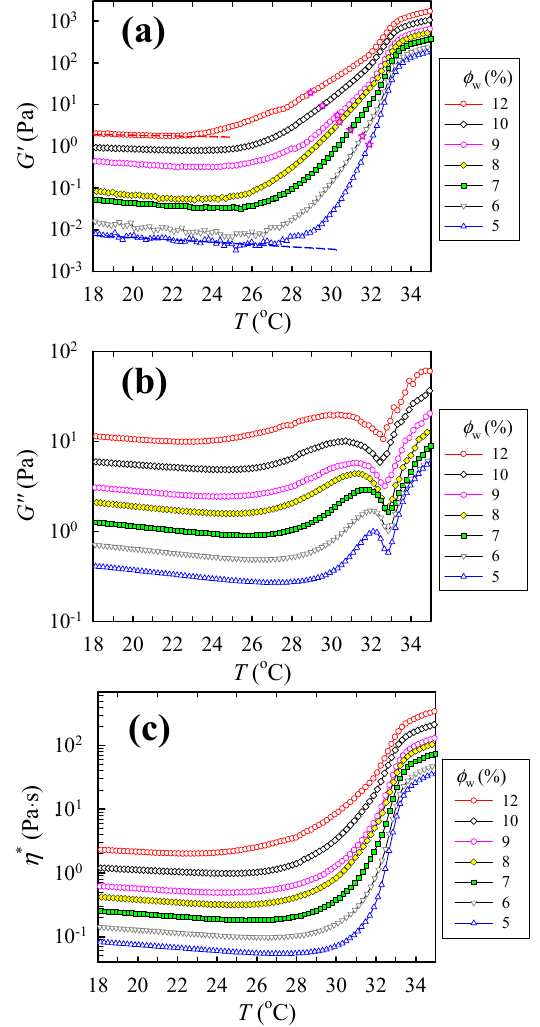
Figure 8. Temperature dependence of ( a ) storage modulus G ′ , ( b ) loss modulus G ″ , and ( c ) complex viscosity η * of a-PNIPAM aqueous solutions of different concentrations during temperature sweep at a heating rate of 0.2 °C/min and applied frequency of 5 rad/s. In ( a ), T cross is represented by the ☆ symbol.